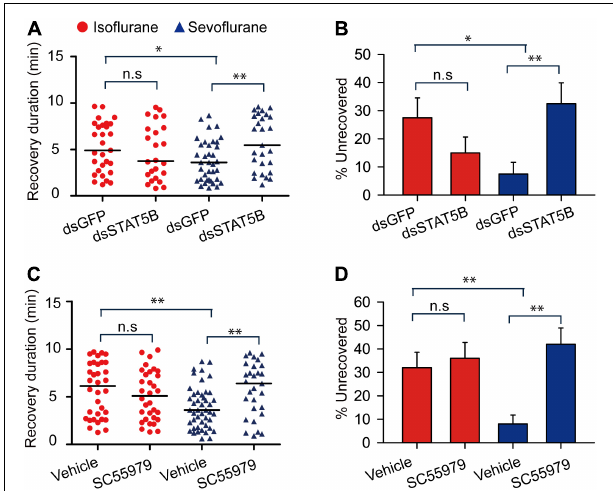
FIGURE 9 | STAT5B mediates the shorter duration of recovery from sevoflurane anesthesia than isoflurane anesthesia. (A,B) STAT5B RNAi knockdown (A) results in longer duration of recovery from sevoflurane anesthesia, and increases the percentage of unrecovered locusts with sevoflurane anesthesia (B) within 10 min after discontinuing anesthesia ( n = 40 for each treatment). (C,D) Injection of STAT5B inhibitor SC55979 (C) results in longer duration of recovery from sevoflurane anesthesia, and increases the percentage of unrecovered locusts with sevoflurane anesthesia (D) within 10 min after discontinuing anesthesia ( n = 40 for each treatment). Mann–Whitney U test is used for analyzing differential recovery duration from isoflurane and sevoflurane anesthesia, and G-test for independence is used for analyzing the effects of JAK deficiency on the percentage of unrecovered locusts within 10 min after discontinuing anesthesia. n.s P > 0.05, ∗∗ P < 0.01, ∗ P < 0.05. ISO, isoflurane, SEV, sevoflurane, STAT5B, signal transducer and activator of transcription